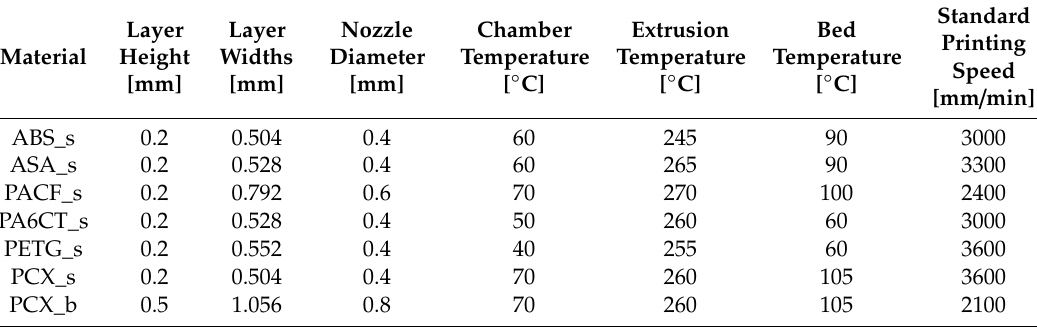
Table 3. Printing properties (s: standard nozzle, b: bolt